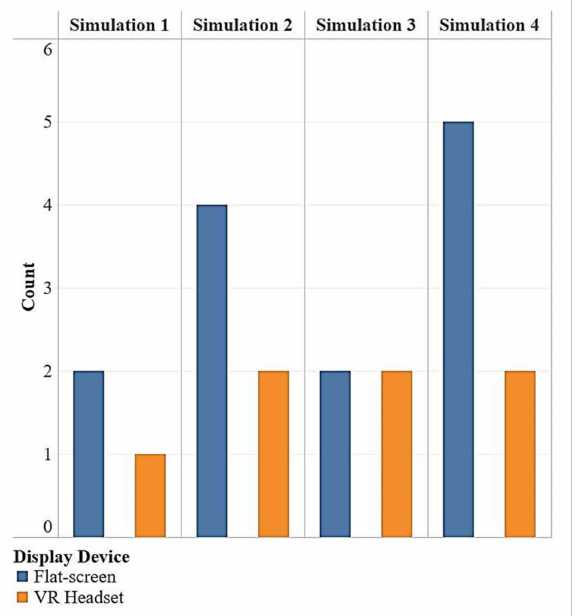
Figure 9. Total number of false identifications in each